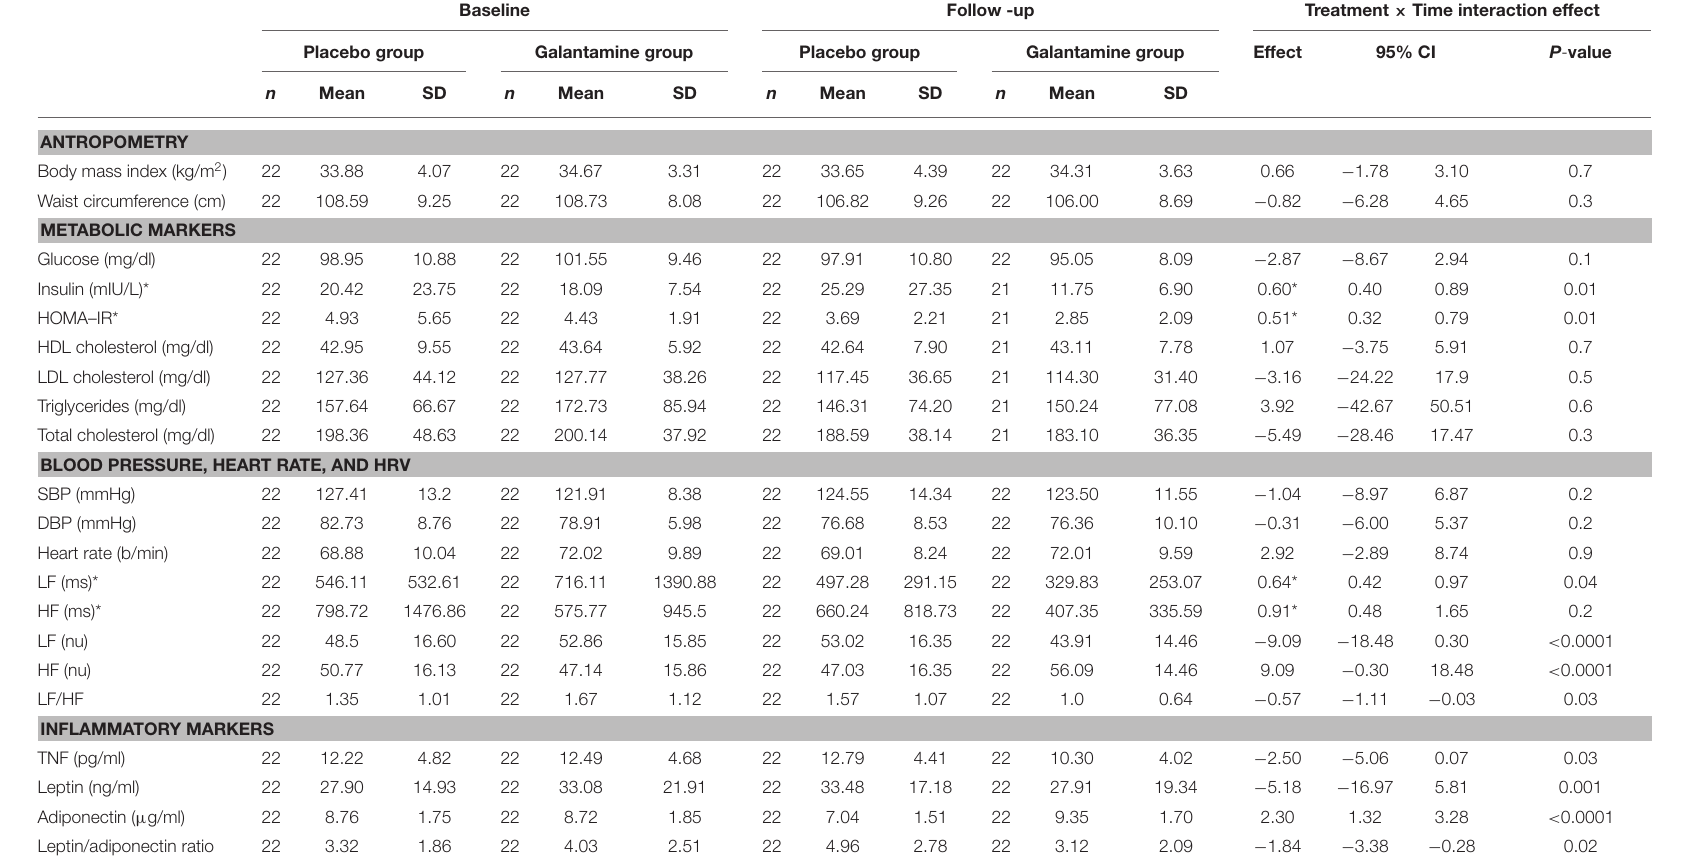
TABLE 3 | Effect of galantamine on metabolic, hemodynamic, and inflammatory markers. Baseline Follow -up Treatment × Time interaction effect Placebo group Galantamine group Placebo group Galantamine group Effect 95% CI P -